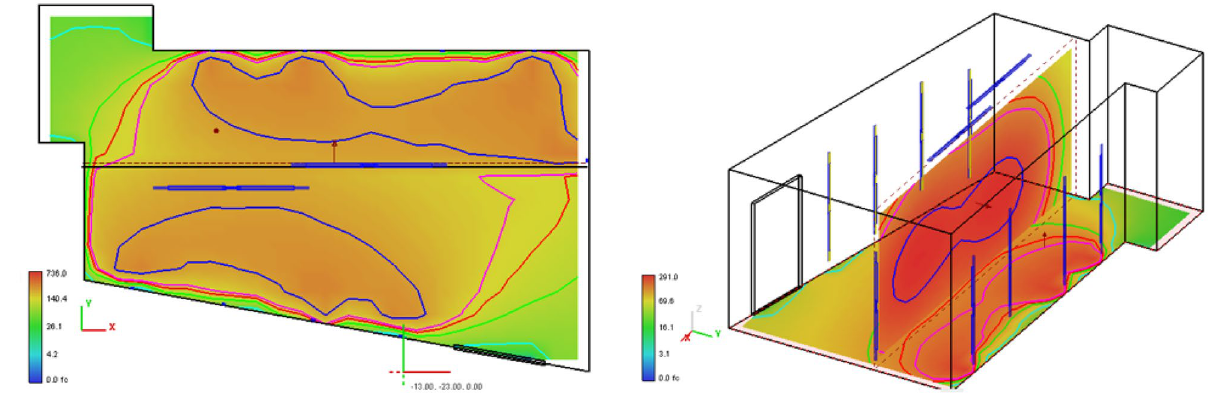
Figure 4. UV power density on the floor (left) and through a vertical plane spanning the center of the room